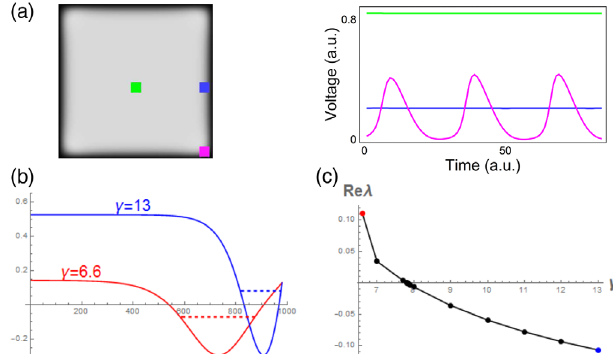
FIG. 5. (a) Localization of oscillations in corners of a bistable domain with zero Dirichlet boundary condition and γ ¼ 8 . 9 . (b) Schrödinger potential wells with ground energy (dashed lines) values for γ ¼ 6 . 6 (red line) and γ ¼ 13 (blue line). (c) Stability parameter Re λ for different values of γ , from the ground energy calculation of the Schrödinger eigenvalue problem. The points corresponding to γ ¼ 6 . 6 and γ ¼ 13 are indicated by red and blue dots, respectively, for matching with the potential well profiles in